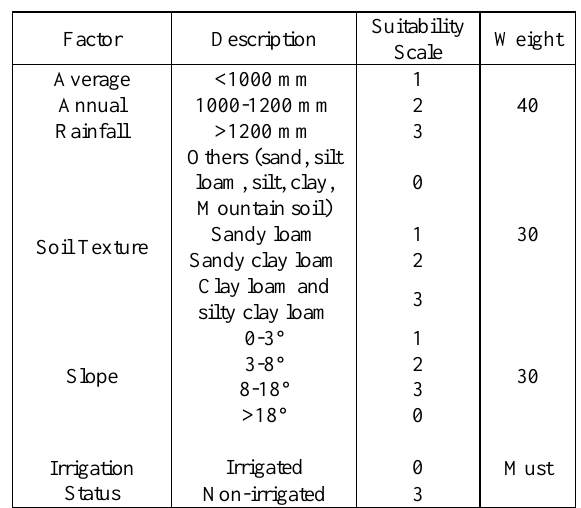
Table 1: Standardized weight distribution for SFR suitability map